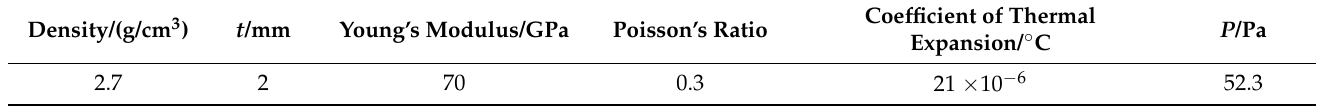
Table 1. Main parameters used in design of the truss-structured mirrors.